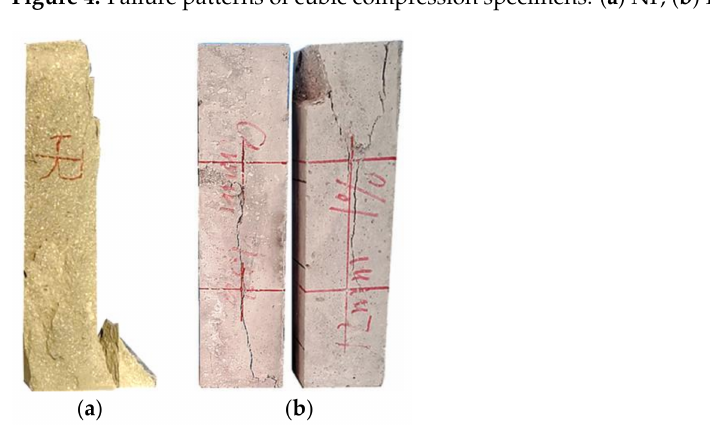
Figure 4. Failure patterns of cubic compression specimens. ( a ) NF, ( b ) PVA.